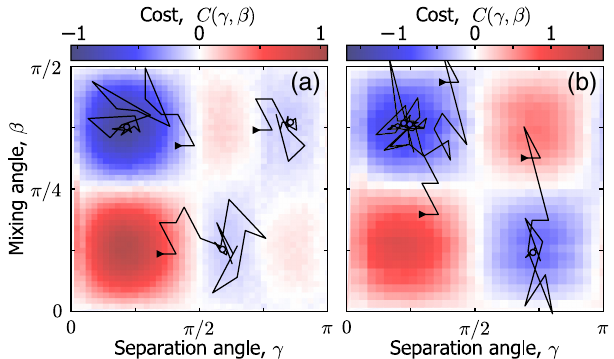
FIG. 14. Overlay of three selected convergence traces on the cost-function landscape of the (a) three-qubit and (b) seven- qubit problem instance. The random initialization is shown with a black triangle and the final location of each trace is indicated by a round marker whose color reflects the cost of the last function